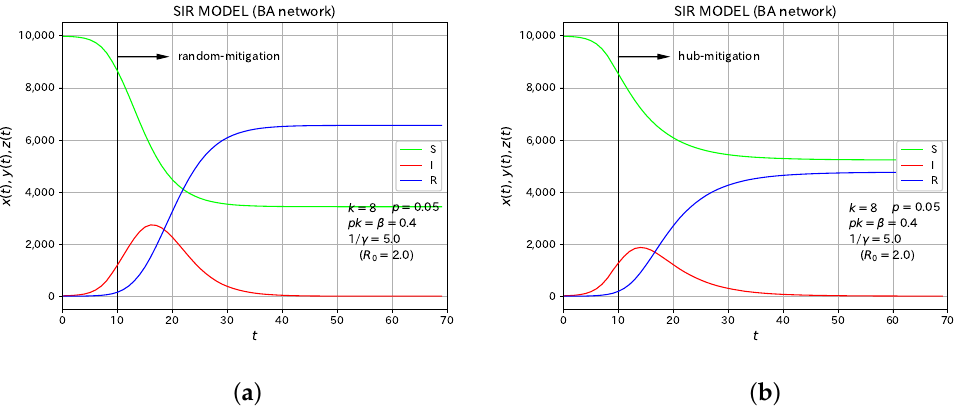
Figure 12. The effects of quarantine for the microscopic SIR model on the BA network. ( a ) At t ≥ 10, 10% nodes randomly chosen are isolated. ( b ) At t ≥ 10, 10% nodes within the hub are isolated. For both cases, an average over 40 samples was